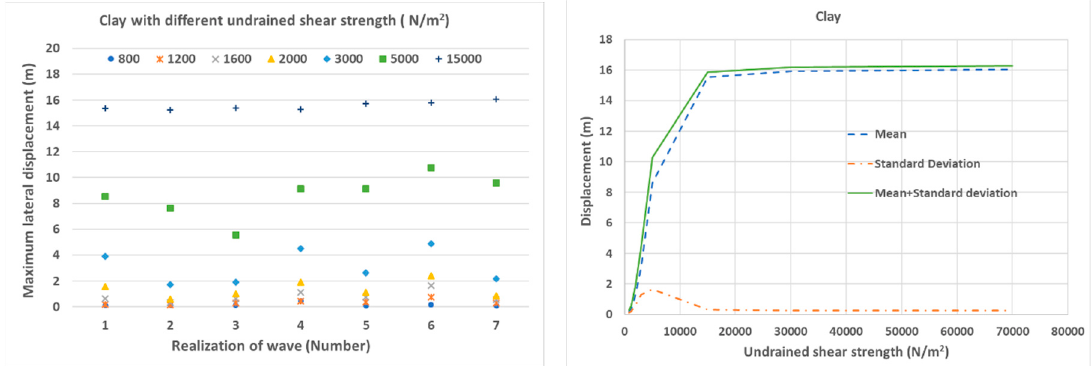
Figure 9. The lateral displacement of the umbilical for seven wave realizations and the mean and standard deviation of lateral displacement (with different undrained shear strength of clay).